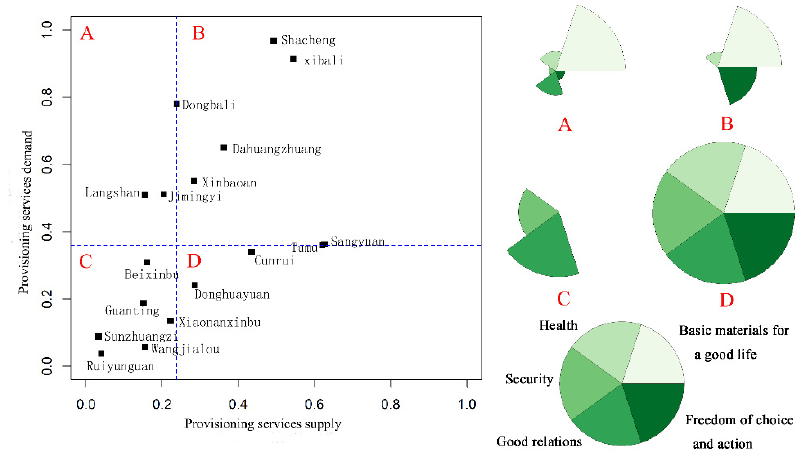
Figure 8. The well-being characteristics of four supply–demand types of provisioning services. Figure 8. The well ‐ being characteristics of four supply–demand types of provisioning services.